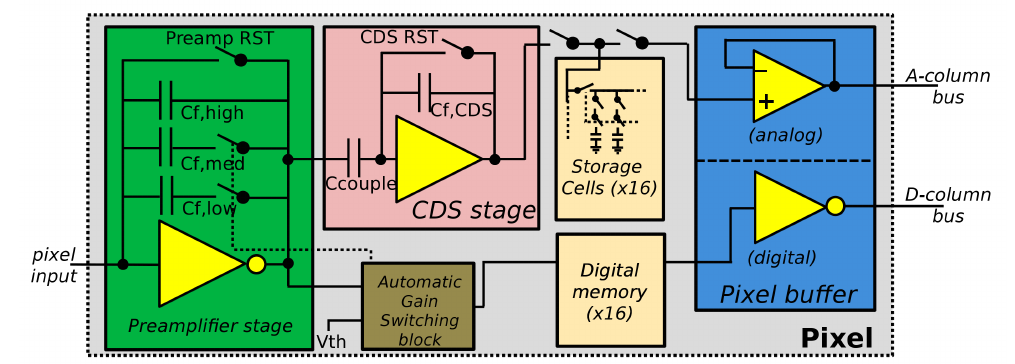
Figure 20. Block view of the pixel architecture. The bypass of the correlated double sampling (CDS) stage after switching is not